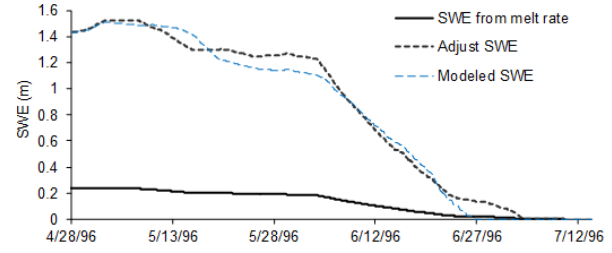
Figure 13. Comparisons of snow water equivalent in 1996 at the subnivean snow laboratory at Niwot Ridge watershed, CO.